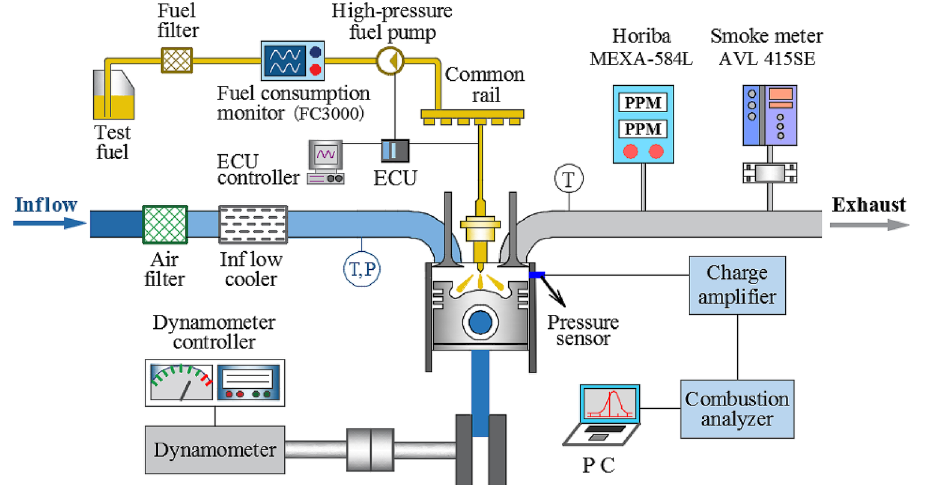
Figure 1. Schematic diagram of the testing apparatus.